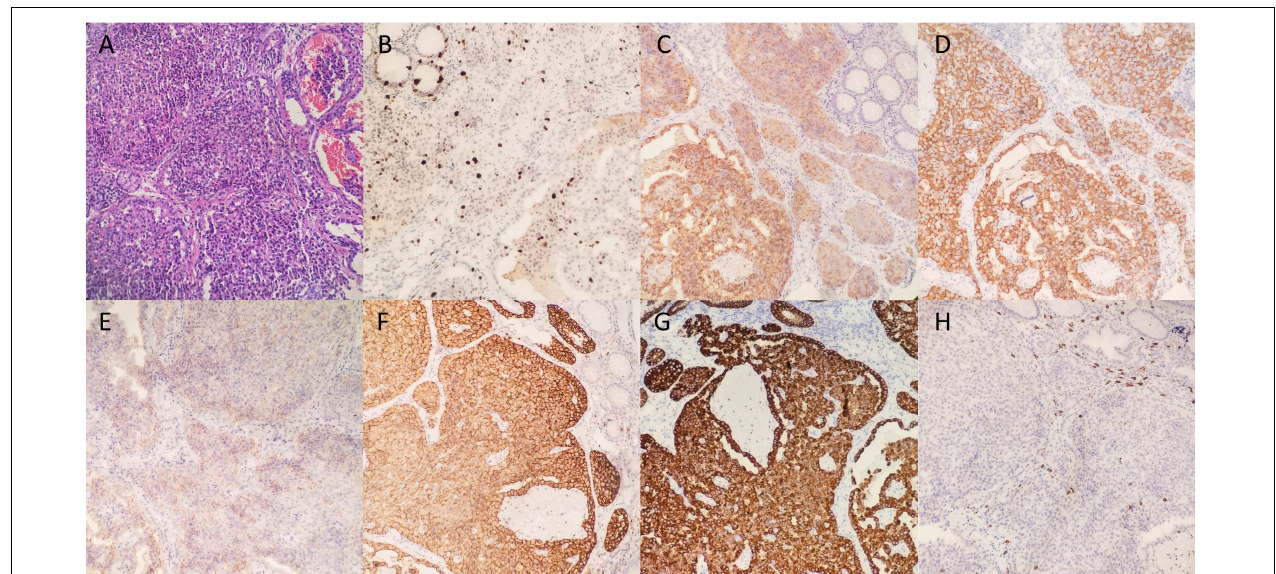
FIGURE 2 | Histological findings of pathological biopsies. (A) Hematoxylin and eosin staining (200x). (B) Ki-67 staining revealed the Ki-67 index was 15% and mitotic rate was 12. The carcinoid showed positive staining of CgA (C) , Syn (D) , CD56 (E) , SSTR2 (F) , CK (G) , and negative staining for CD117 (H) .